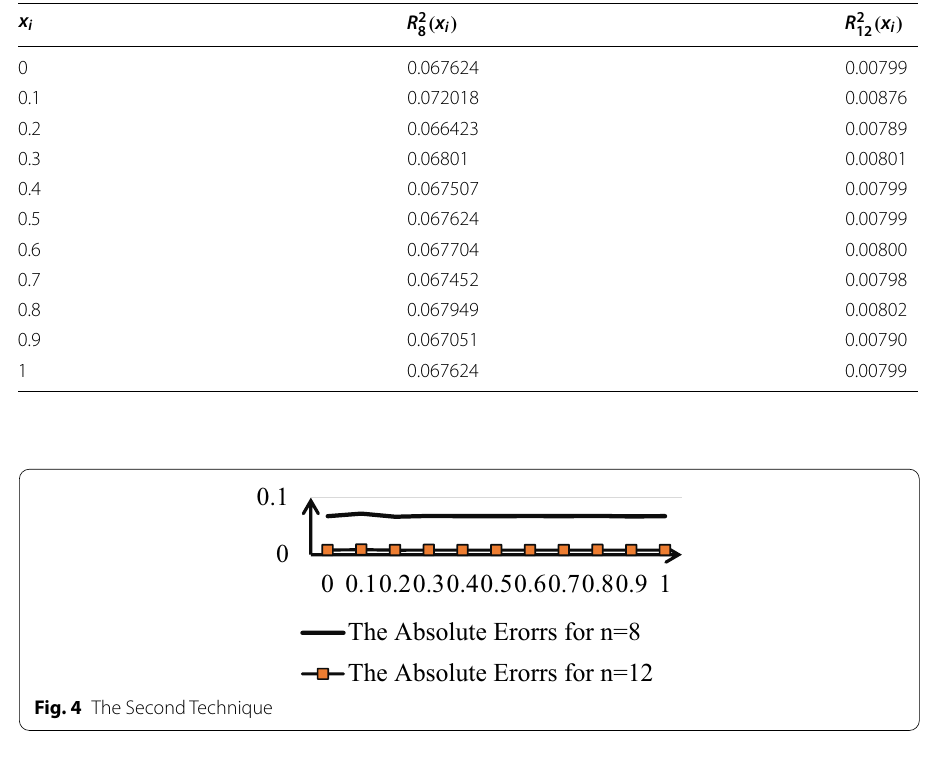
Table 4 The absolute errors R 2 n ( x i ) for n = 8, 12